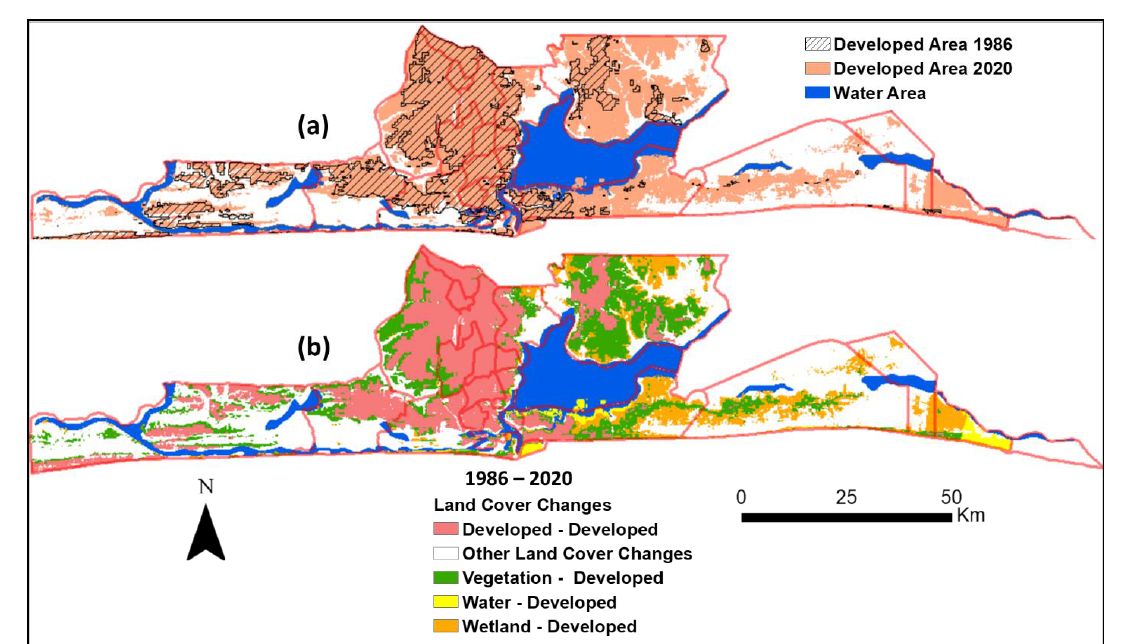
Figure 6. ( a ) The spatial distribution of developed and undeveloped areas in 1986 (hatched areas) and 2020 (solid color). ( b ) The distribution of landcover changes in one land cover type with reference to another land cover type from 1986 to 2020.